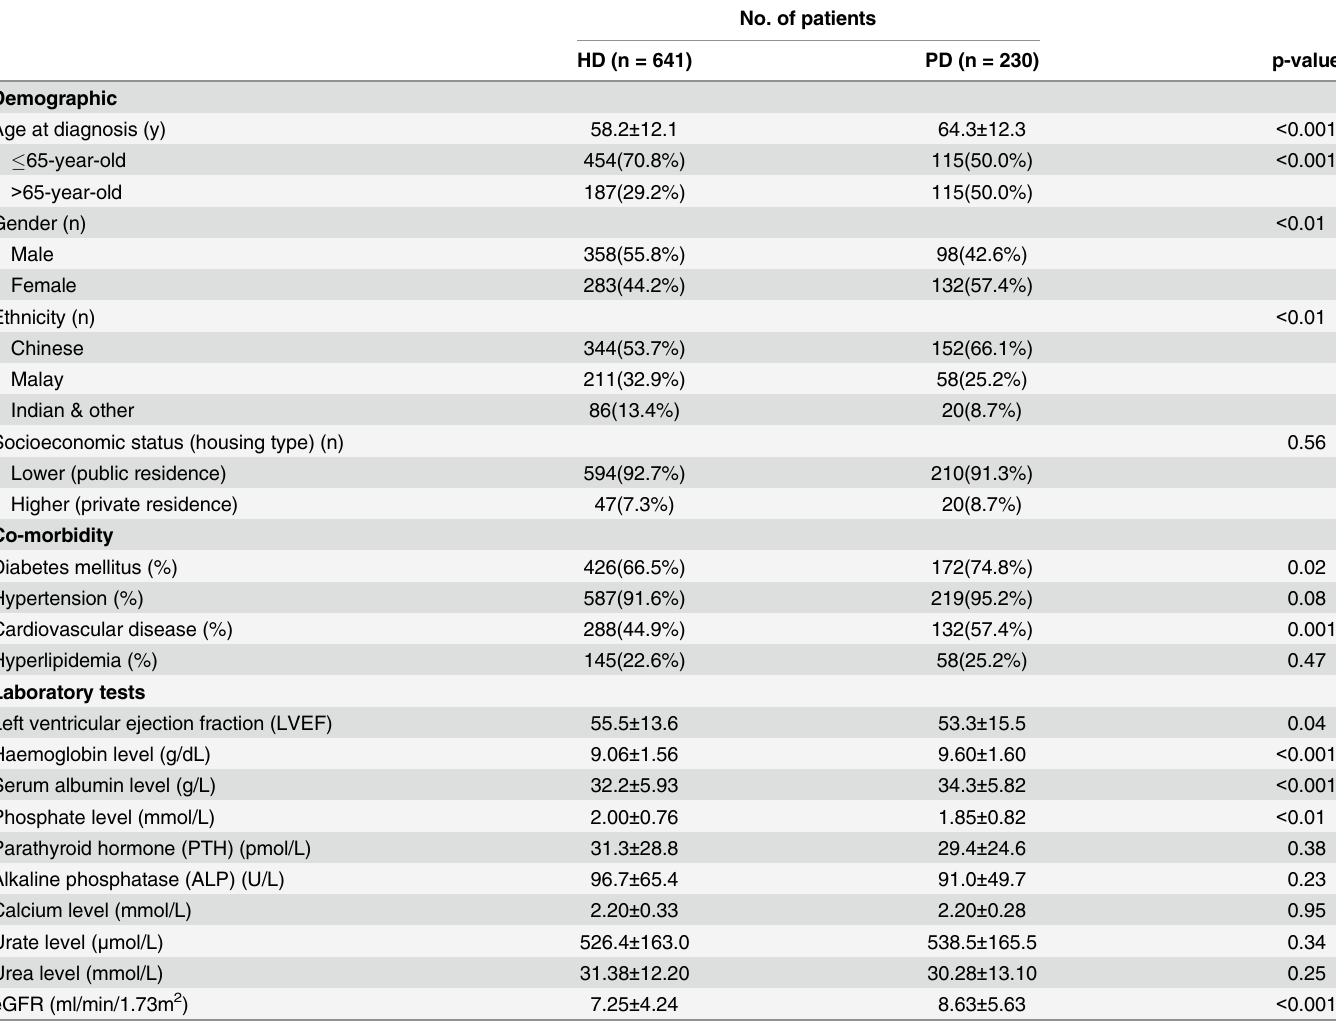
Table 1. Patient characteristics at dialysis